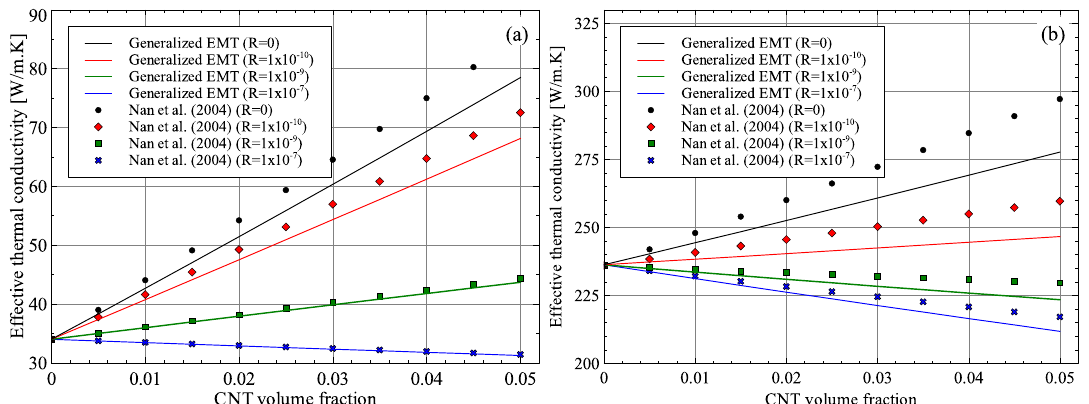
Figure 13. Effective thermal conductivity of: ( a ) Alumina–MWCNT; and ( b ) Aluminum–MWCNT nanocomposites. Table 2. Properties for alumina, aluminum, and MWCNTs.